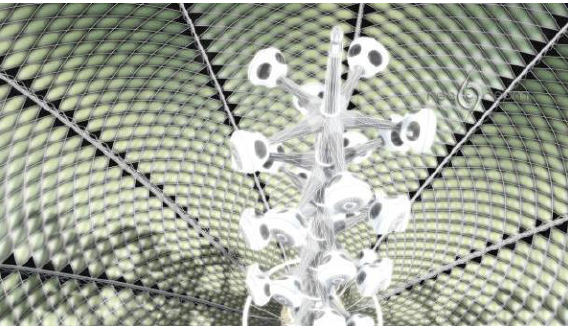
Fig. 1. Solar spore Concept of an algae space